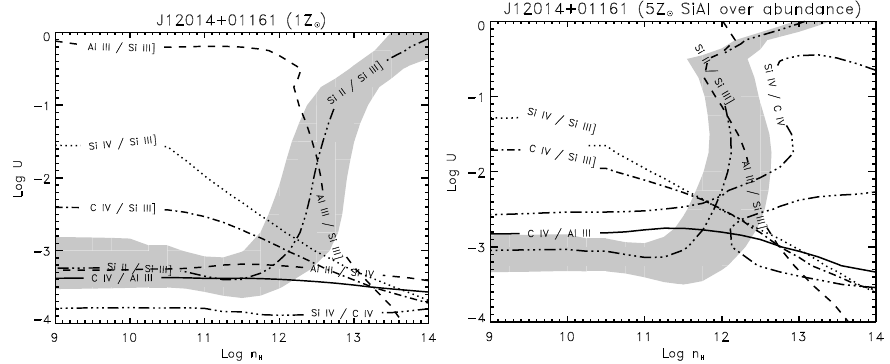
Fig. 2. Constant value contours for several diagnostic ratios in the ionization param- eter versus density plane computed from the spectrum of J120144.36+011611.6. Left: solar metallicity; right: 5 times solar metallicity and Si and Al enrichment. The un- certainty band associated to the ratio Si II (cid:21) 1814 / Si III] (cid:21) 1892 is shown on a shade of